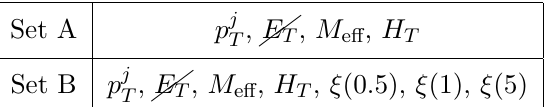
Table 7 . To compare the change in signal signi(cid:12)cance without and with soft tracks we have introduced two sets of variables. Set A includes the conventional set of variables whereas Set B includes the p T binned track information along with the conventional variables.